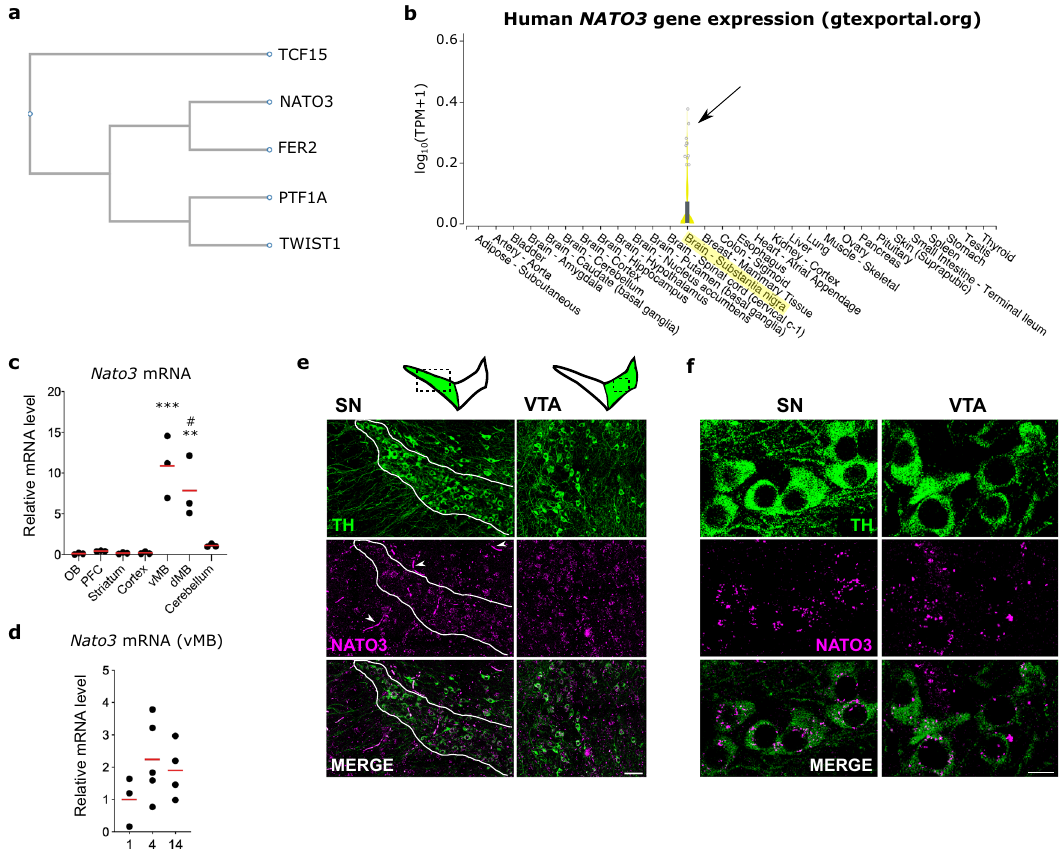
Fig. 5 Nato3 is expressed in the midbrain DA neurons in adult mice. a Phylogenetic tree generated by multiple protein sequence alignment of Drosophila FER2 and mouse TCF15, NATO3, PTF1A and TWIST1, using ClustalW (https://www.genome.jp/tools-bin/clustalw). b NATO3 expression levels in human tissues measured by RNA-seq as reported in GTEx portal (gtexportal.org). c RT-qPCR analysis of Nato3 mRNA expression levels in different brain regions of C57BL6 mice at 4 months. OB, olfactory bulbs. PFC, prefrontal cortex. vMB, ventral midbrain. dMB, dorsal midbrain. Data are represented as scatter dot plots, with the horizontal line representing the mean. n = 3 animals per region. One-way ANOVA followed by a Tukey ’ s test for multiple group comparison. vMB vs. any region other than dMB, *** p < 0.001 (OB vs. vMB, p = 0.0002. OB vs. dMB, p = 0.0050. PFC vs. vMB, p = 0.0003. Striatum vs. vMB, p = 0.0002. Cortex vs. vMB, p = 0.0002. Cerebellum vs. vMB, p = 0.0006). dMB vs. any other region than vMB and cerebellum, ** p < 0.01 (OB vs. dMB, p = 0.0066. PFC vs. dMB, p = 0.0071. Striatum vs. dMB, p = 0.0054. Cortex vs. dMB, p = 0.0056). dMB vs. cerebellum, # p = 0.0150. d RT-qPCR analysis of Nato3 mRNA expression levels in the ventral midbrain of C57BL6 mice at different ages. Data are represented as scatter dot plots, with the horizontal line representing the mean of the fold change relative to the expression at 1 month. n = 3 (1 month), n = 5 (4 months), n = 4 (14 months) animals per group. No statistically signi fi cant difference between different ages by ANOVA. e Representative images of Nato3 (magenta) in situ hybridization in coronal sections of the ventral midbrain of 4-month-old C57BL6 mice. Arrowheads indicate nonspeci fi c signals. mDA neurons were detected by anti-TH antibodies (green). Scale bar, 50 μ m. 3 coronal sections per animal from 2 independent animals were analyzed. f High magni fi cation images of Nato3 (magenta) in situ hybridization of SN and VTA mDA neurons detected by anti-TH antibodies (green). 3 coronal sections per animal from 2 independent animals were analyzed. Scale bar, 10 μ